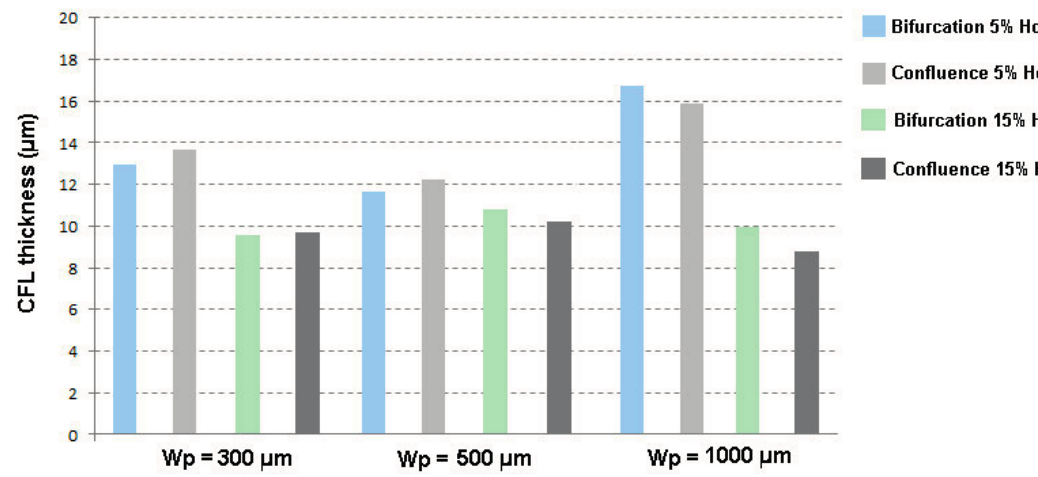
Figure 10. CFL thickness measured in blood flows of 5% Hct and 15% Hct in a microchannel with a diverging and converging bifurcation for a width of the parent channel (Wp) of 300, 500, and 1000 μ m. The flow rate was 10 μ L/min.